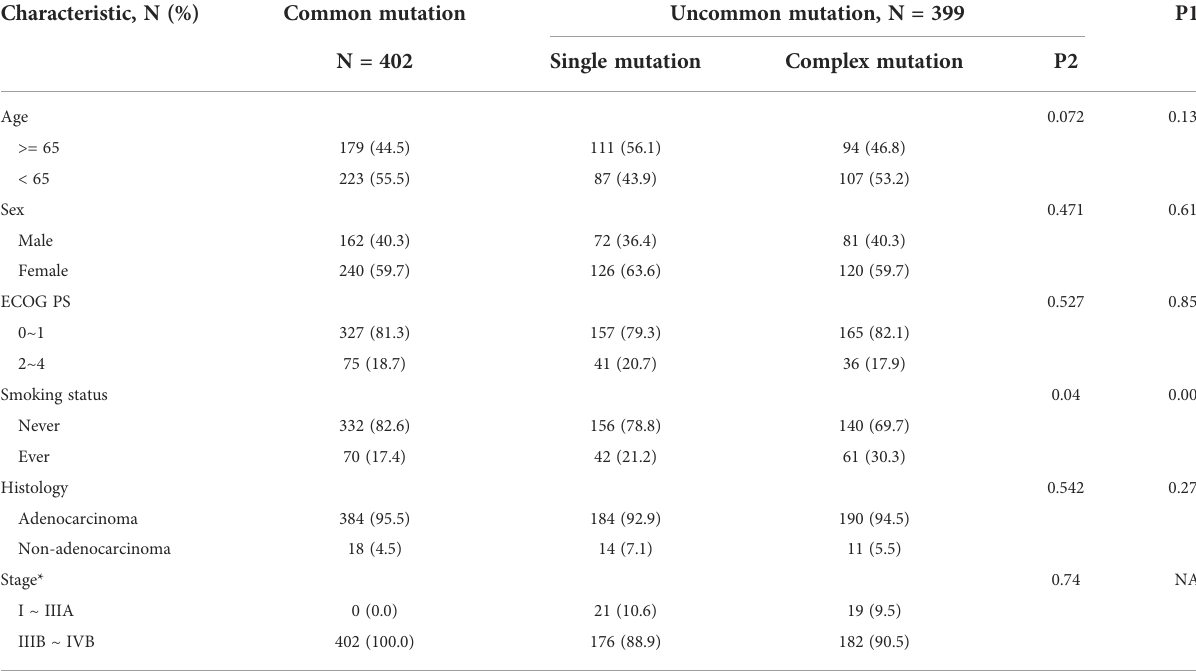
TABLE 1 Demographic data of NSCLC patients harboring common and uncommon EGFR